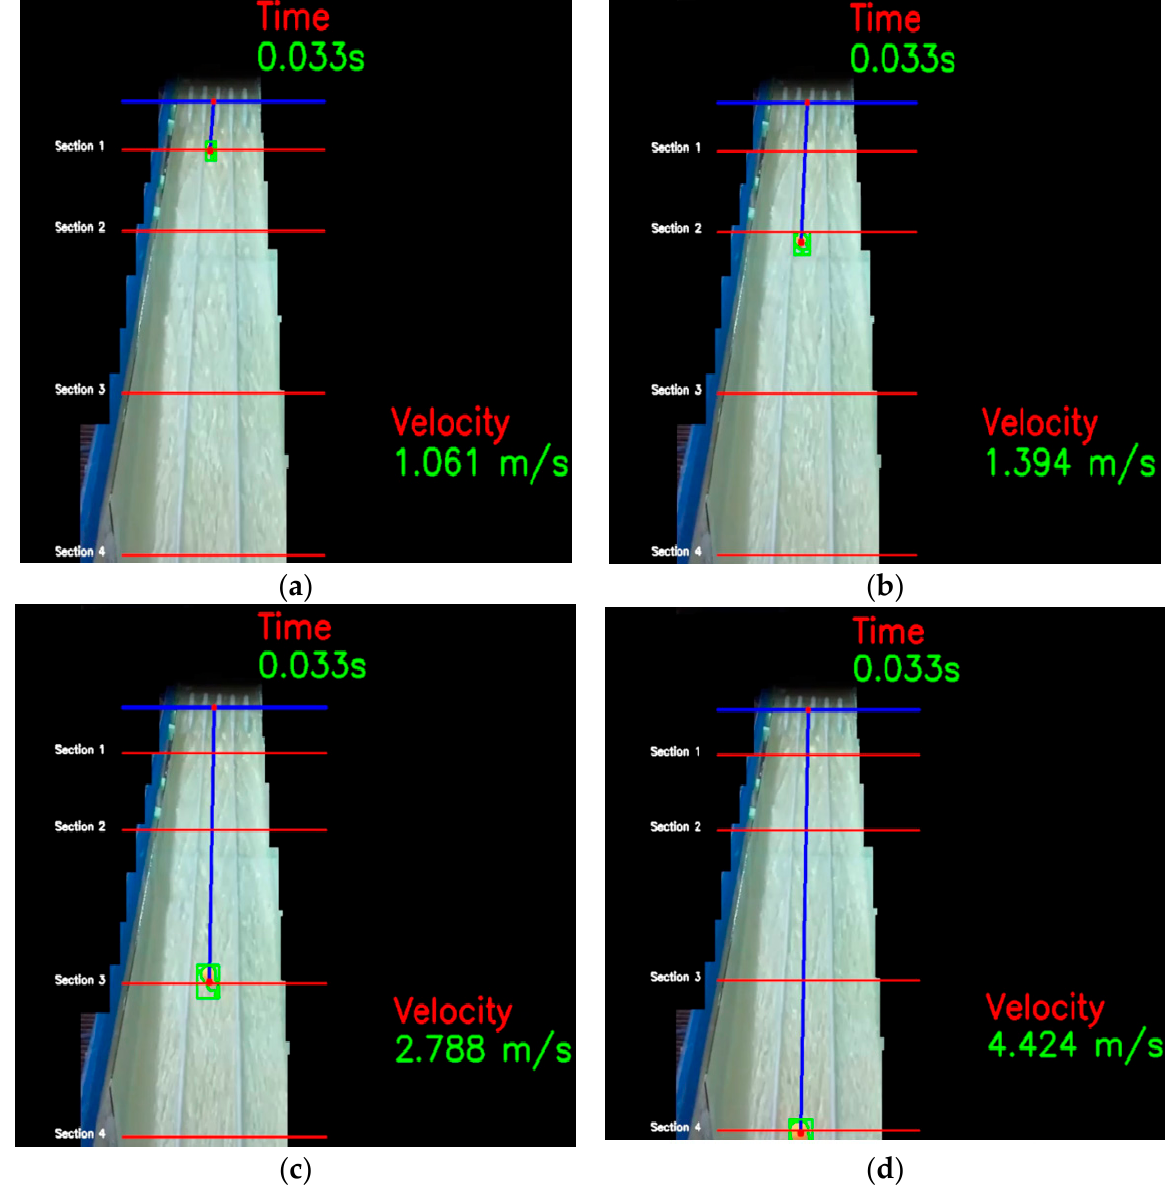
Figure 29. Floating object velocity values obtained with OpenCV code: ( a ) Cross-section 1; ( b ) Cross- section 2; ( c ) Cross-section 3; ( d ) Cross-section 4. (Red lines indicate cross-section locations, blue lines indicate the distance of the float from the origin).